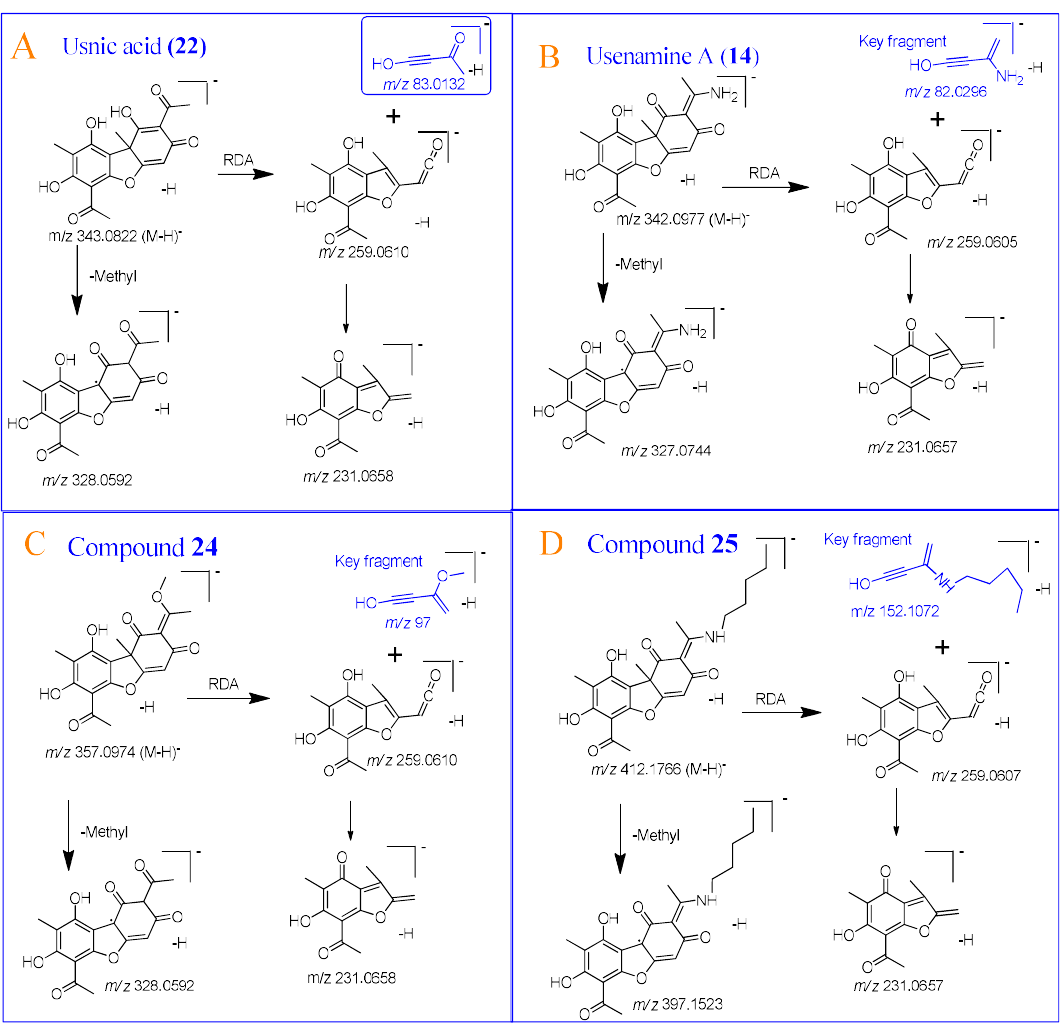
Figure 5. Comparative fragmentation study of ( A ) Usnic acid ( 22 ), ( B ) Usenamine A ( 14 ), ( C ) Compound 24 and ( D ) Compound 25 .